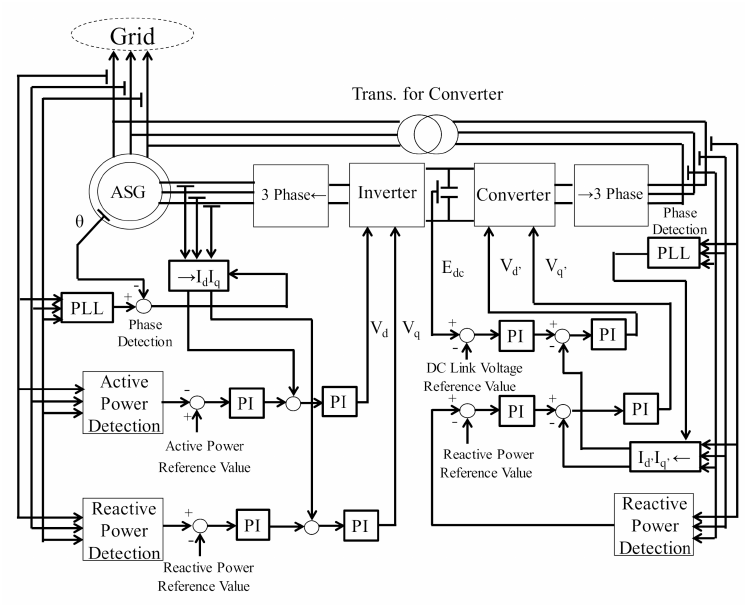
Figure 7. Detailed structure of the ASG rotor excitation